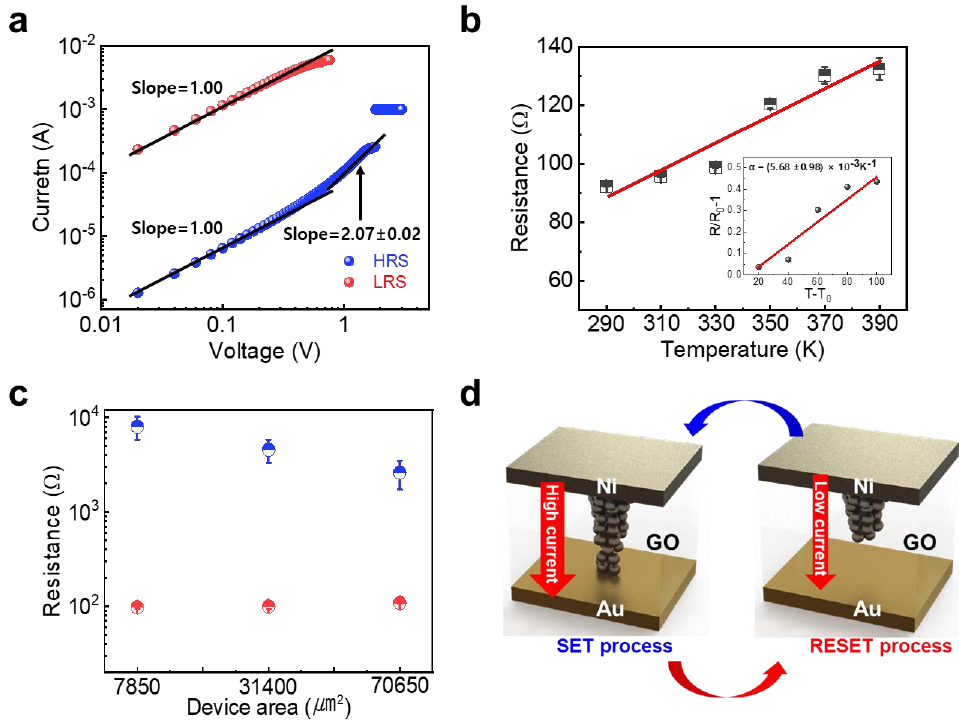
Figure 2. ( a ) I-V characteristics plotted on double-logarithmic scale, ( b ) temperature-dependent resistance in LRS, and ( c ) area-dependent resistance of GO-based memristor. ( d ) Schematic of the operational switching mechanism of GO-based